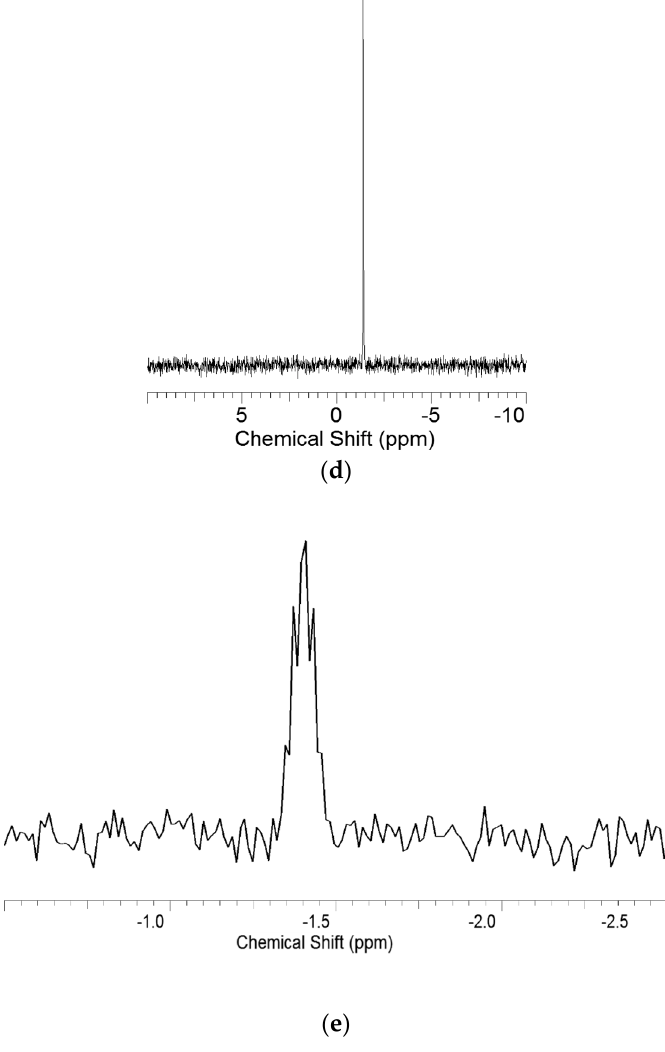
Figure 3. ( a ) 1 H NMR spectra of N faction; ( b ) 1 H NMR spectra of F1 faction; ( c ) 13 C NMR spectra of F1 fraction; ( d ) The proton-decoupled 31 P NMR spectrum of F1 fraction; ( e ) The proton-coupled 31 P NMR spectrum of F1 fraction.